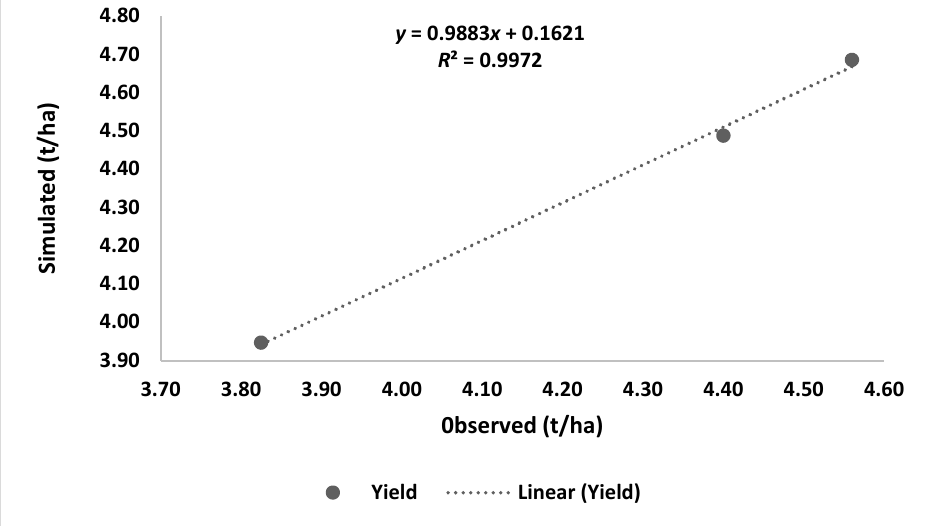
Figure 2. Simulated vs. measured final grain yield for all three growing seasons.